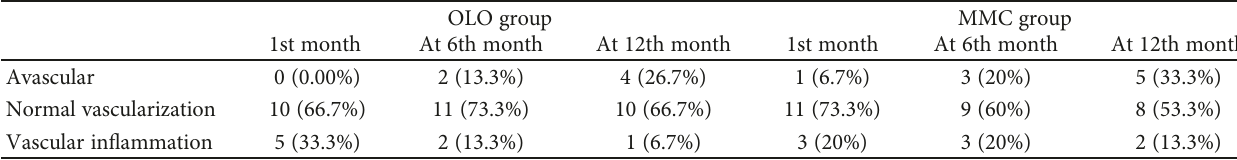
Table 3: Bleb vascularity during follow-up in both